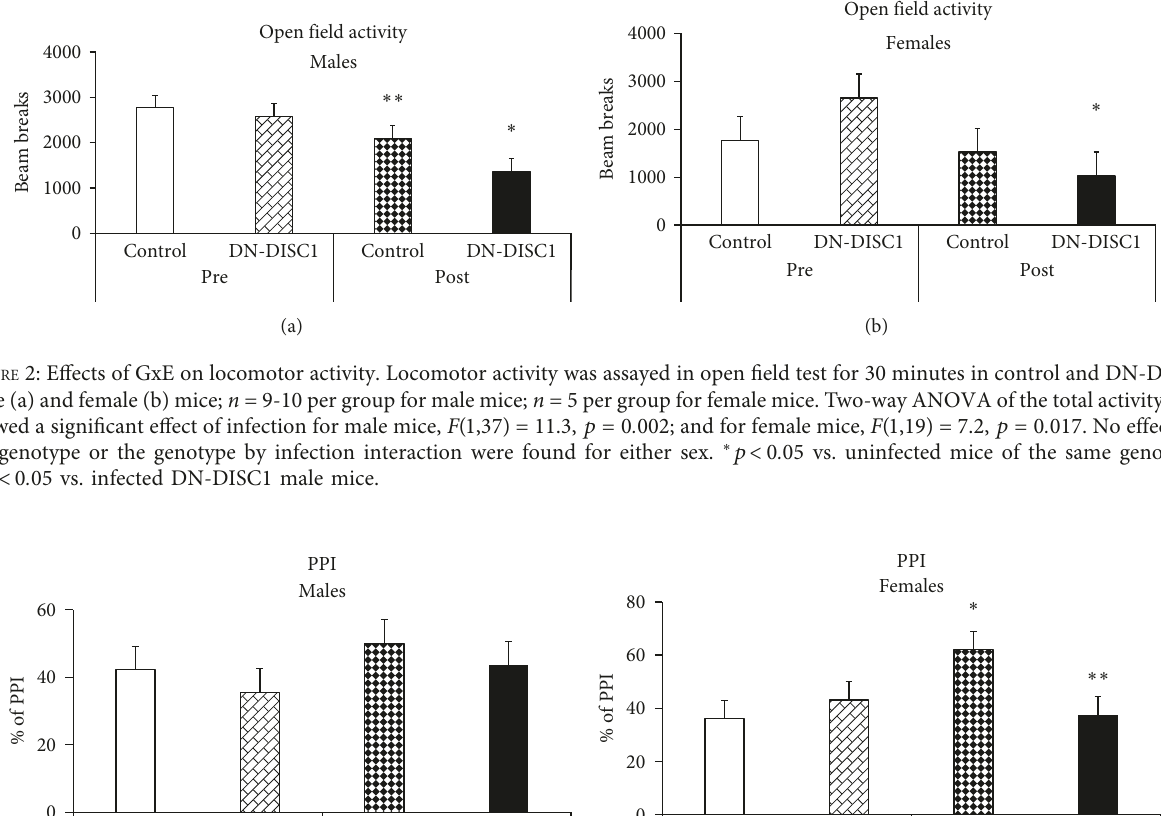
9-10 per (cid:31)